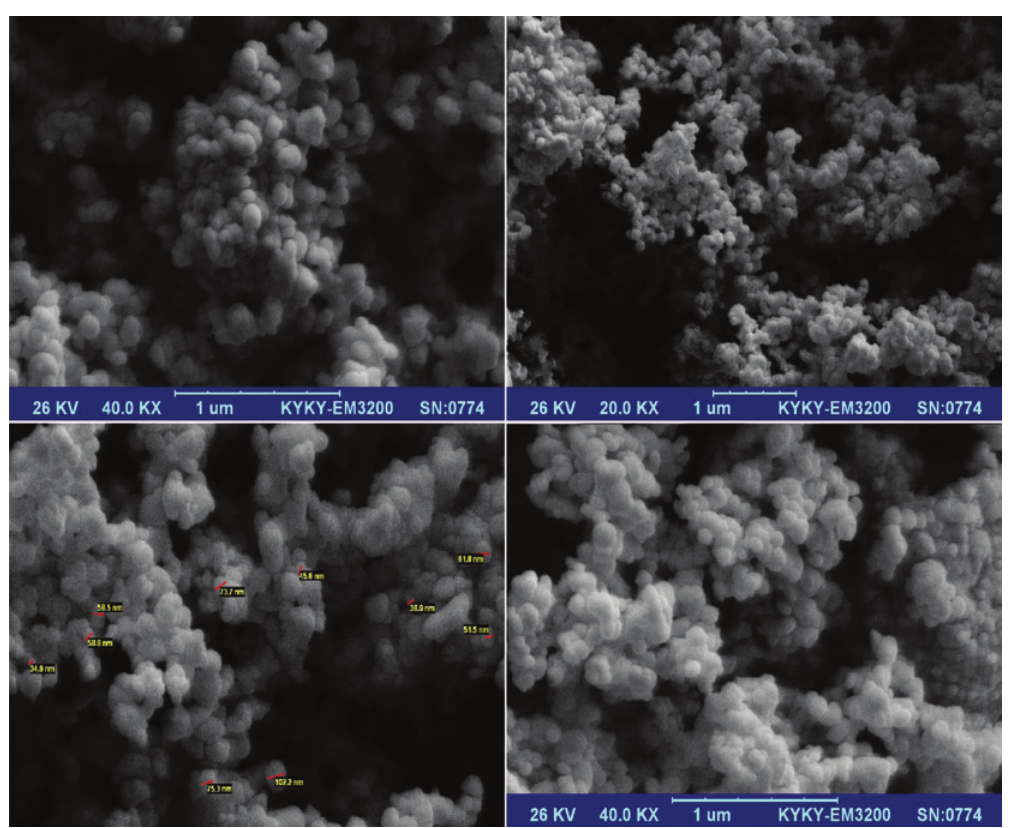
nanoparticles via the sol-gel method. 2